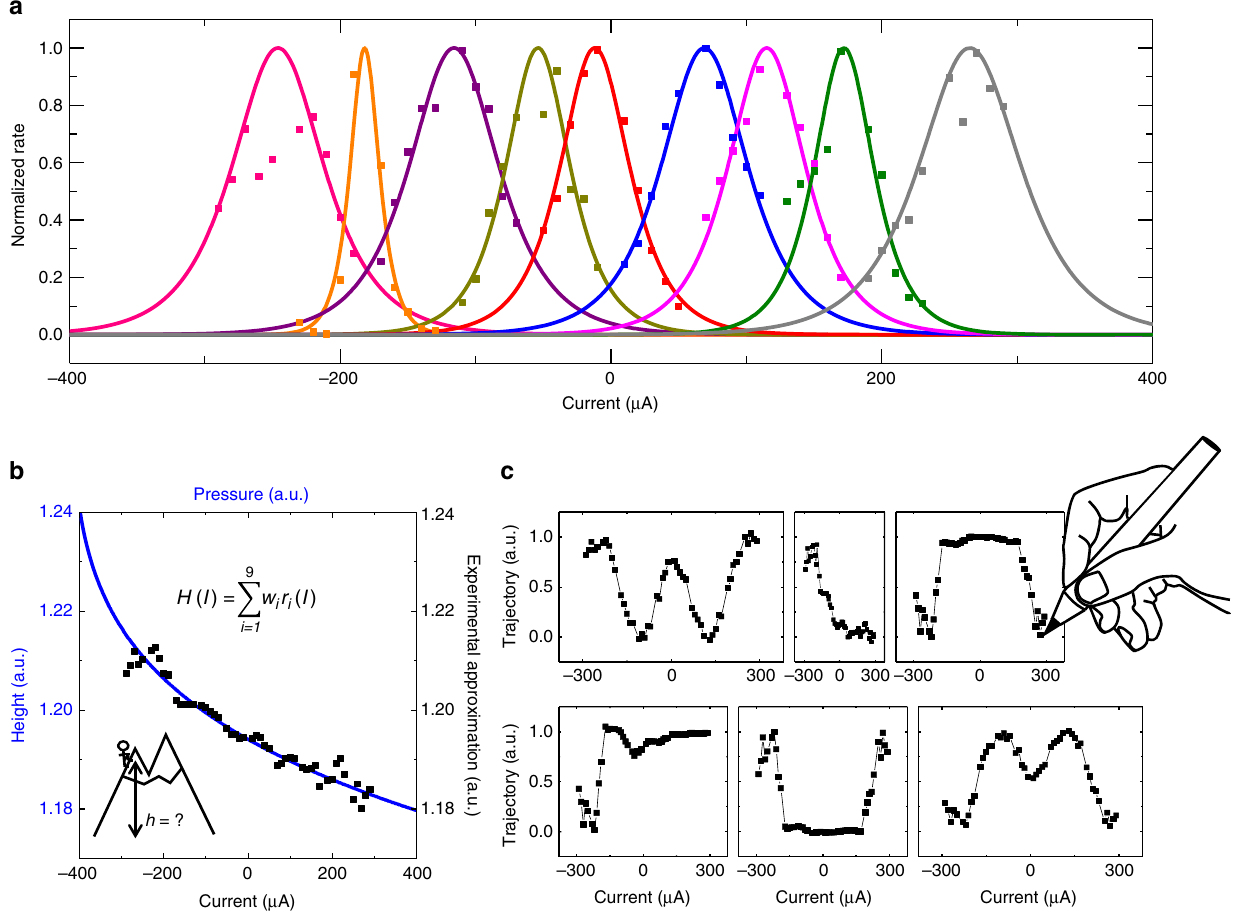
Fig. 2 Representing non-linear functions with superparamagnetic tunnel junctions. a Rates versus current for nine superparamagnetic tunnel junctions with shifted tuning curves. Symbols correspond to experimental data while solid lines are analytical fi ts with Eq. 1. The switching rate of each junction is normalized by its natural rate r 0 . b Example of the altimeter sensor. The solid blue line corresponds to the barometric formula, converting an air pressure measurement into the local height. The black symbols correspond to the experimental approximation of this function generated with Eq. 3, using the basis set data from a and performing the weighted sum with a computer. c Six examples of cursive letters (w, i, n, r, u, m) generated from the experimental junction tuning curves of a following the same procedure as in